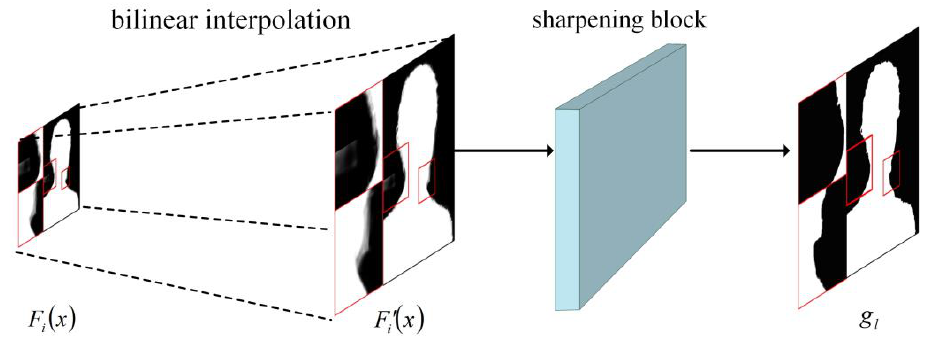
Figure 3. Contour sharpness refinement network.